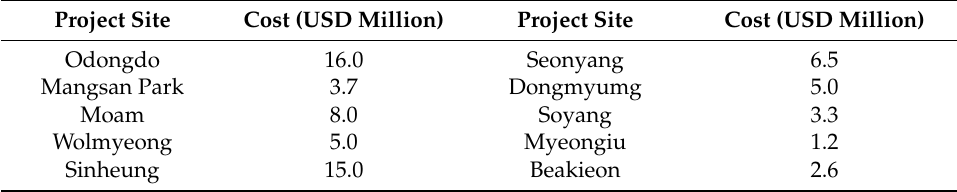
Table 6. Cost of project